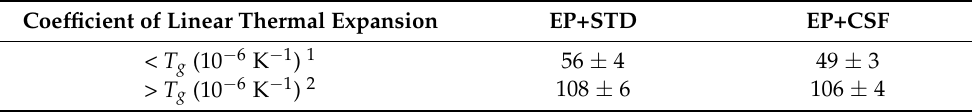
Table 5. Coefficient of linear thermal expansion below and above the T g .